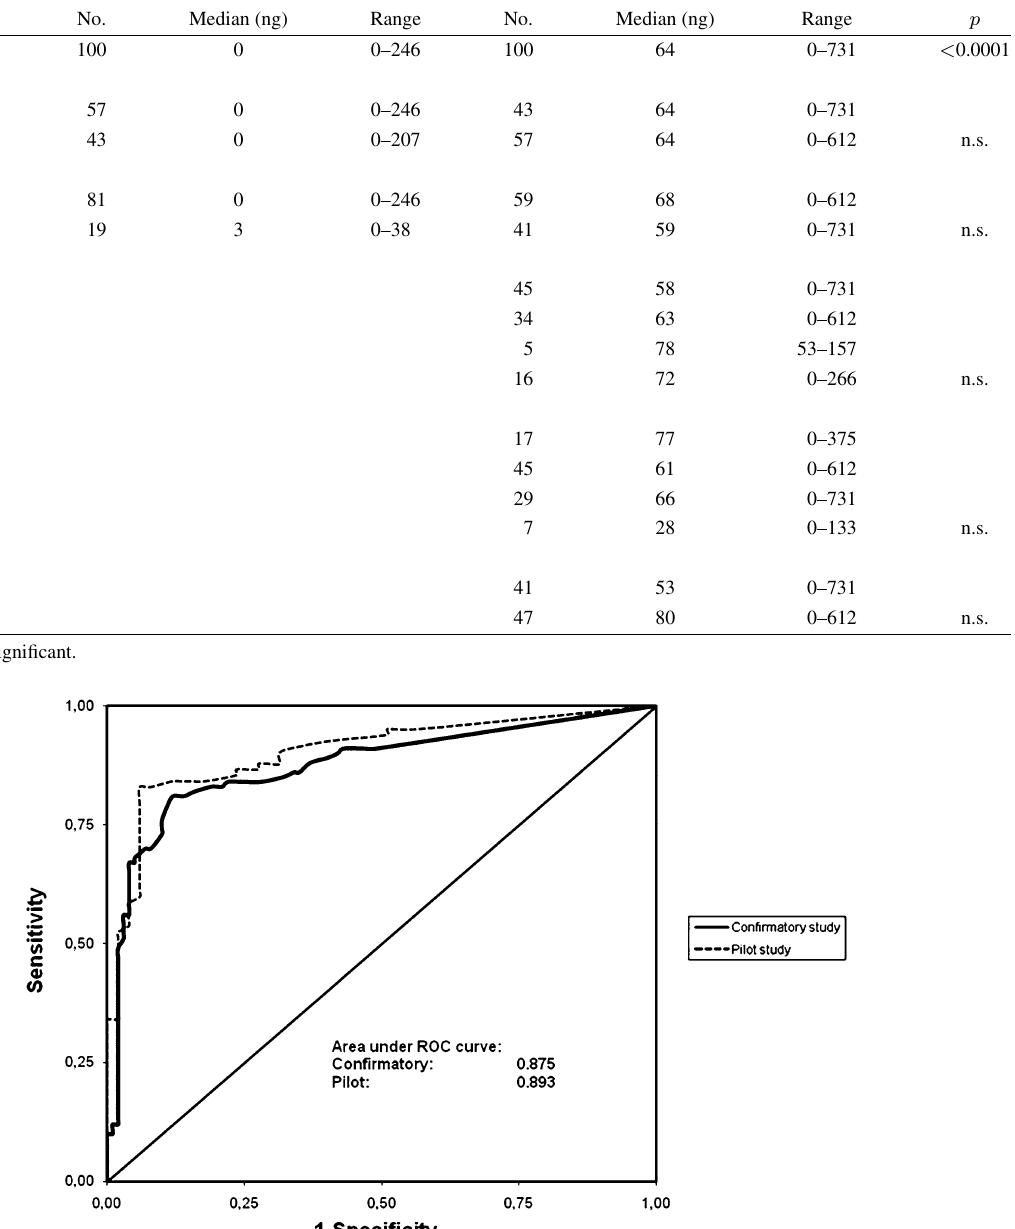
and to biases occurring during the pre-analytical phase. Bleeding and inflammation consequent to colonoscopy can cause falsely elevated long DNA levels and